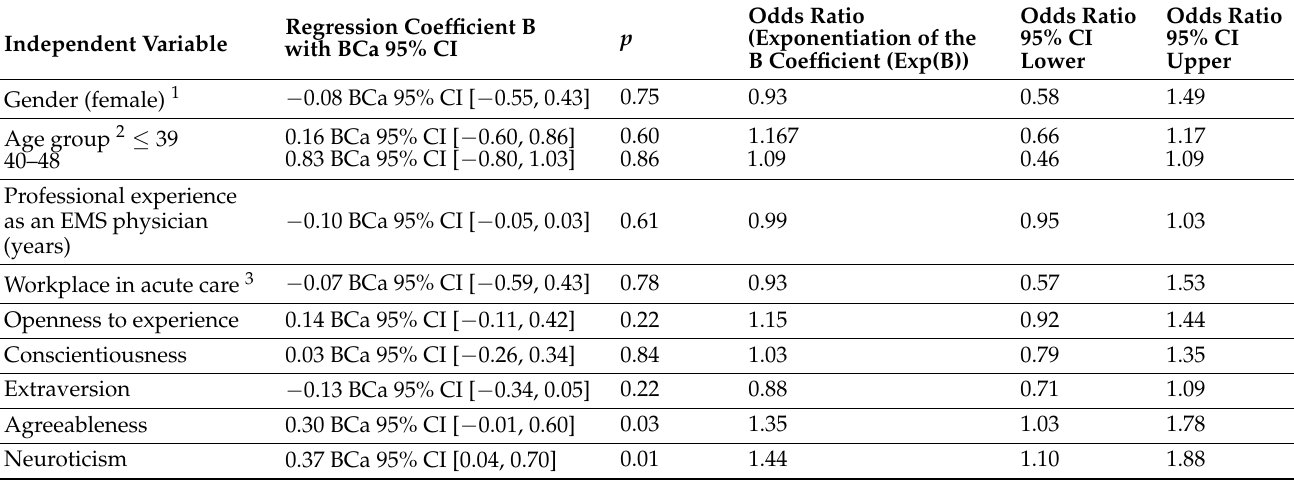
Table 2. Risk factors for becoming a Second Victim. Results of binary logistic